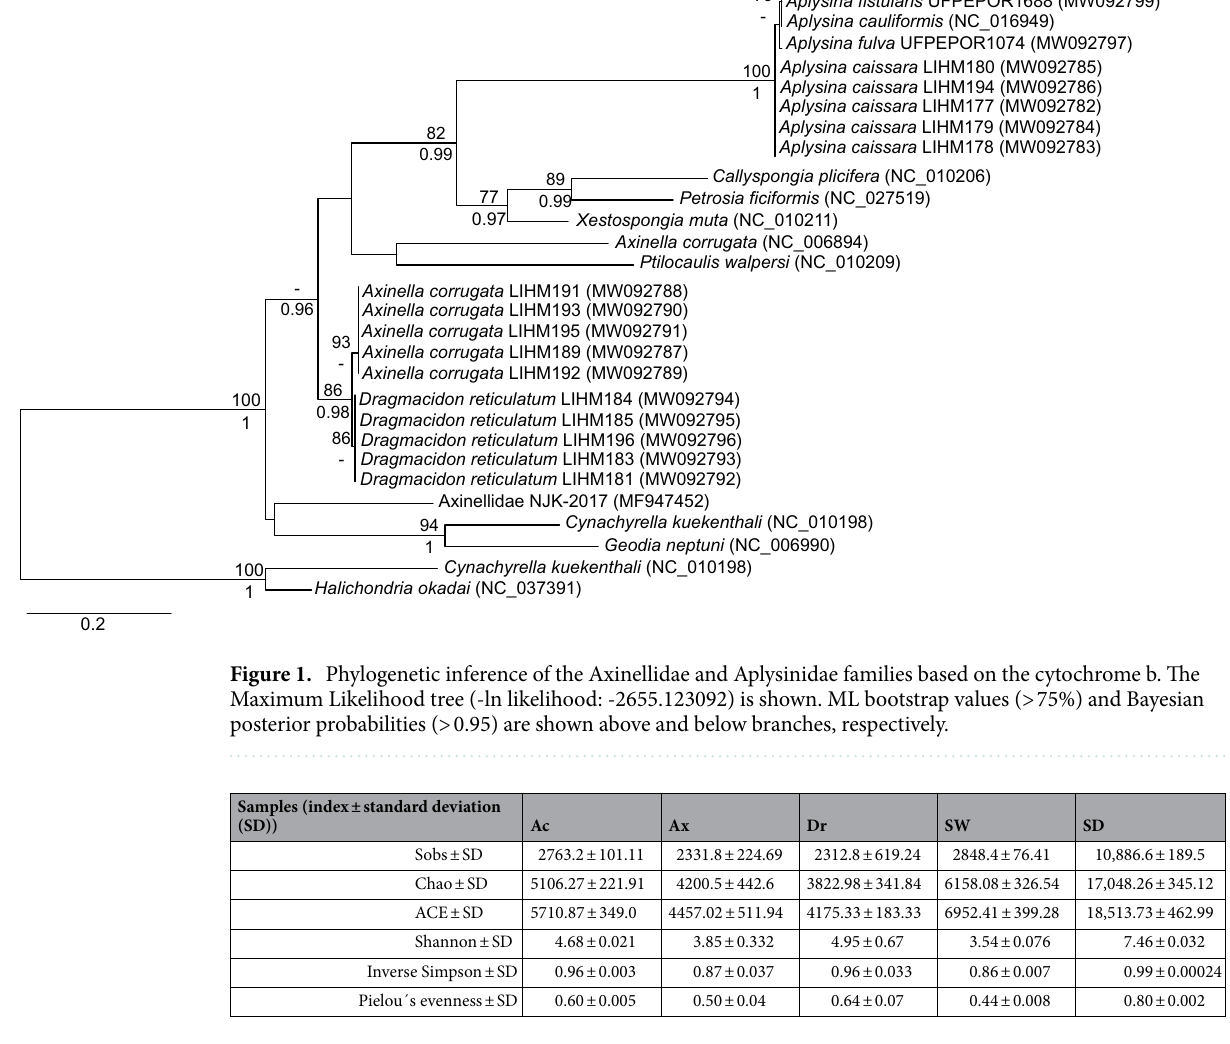
Table 1. Values for richness, diversity and evenness indices. Ac: Aplysina caissara , Ax: Axinella corrugata , Dr: Dragmacidon reticulatum , SW: seawater, SD: sediment, Sobs: estimated richness.